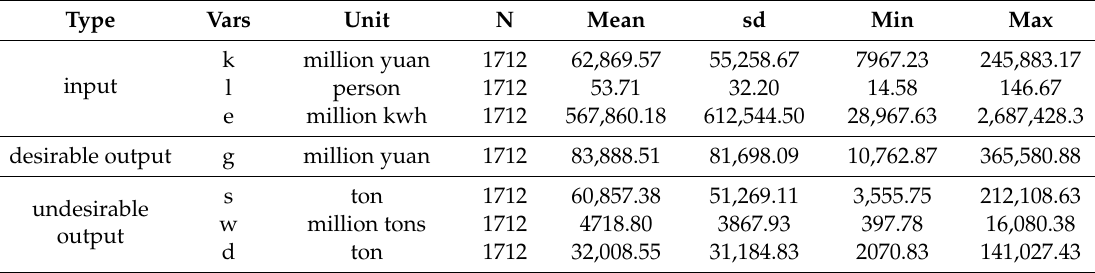
Table 1. Descriptive statistics of input-output variables from